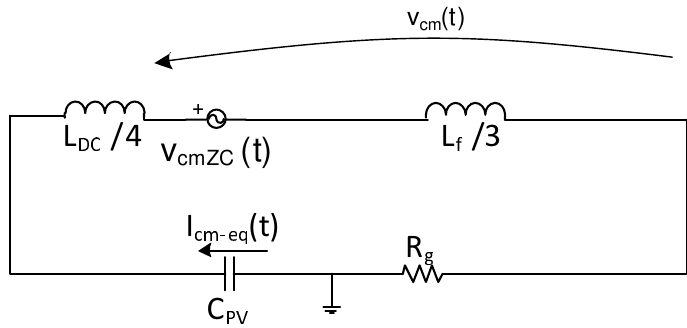
Figure 8. Equivalent common mode circuit in Active state condition.